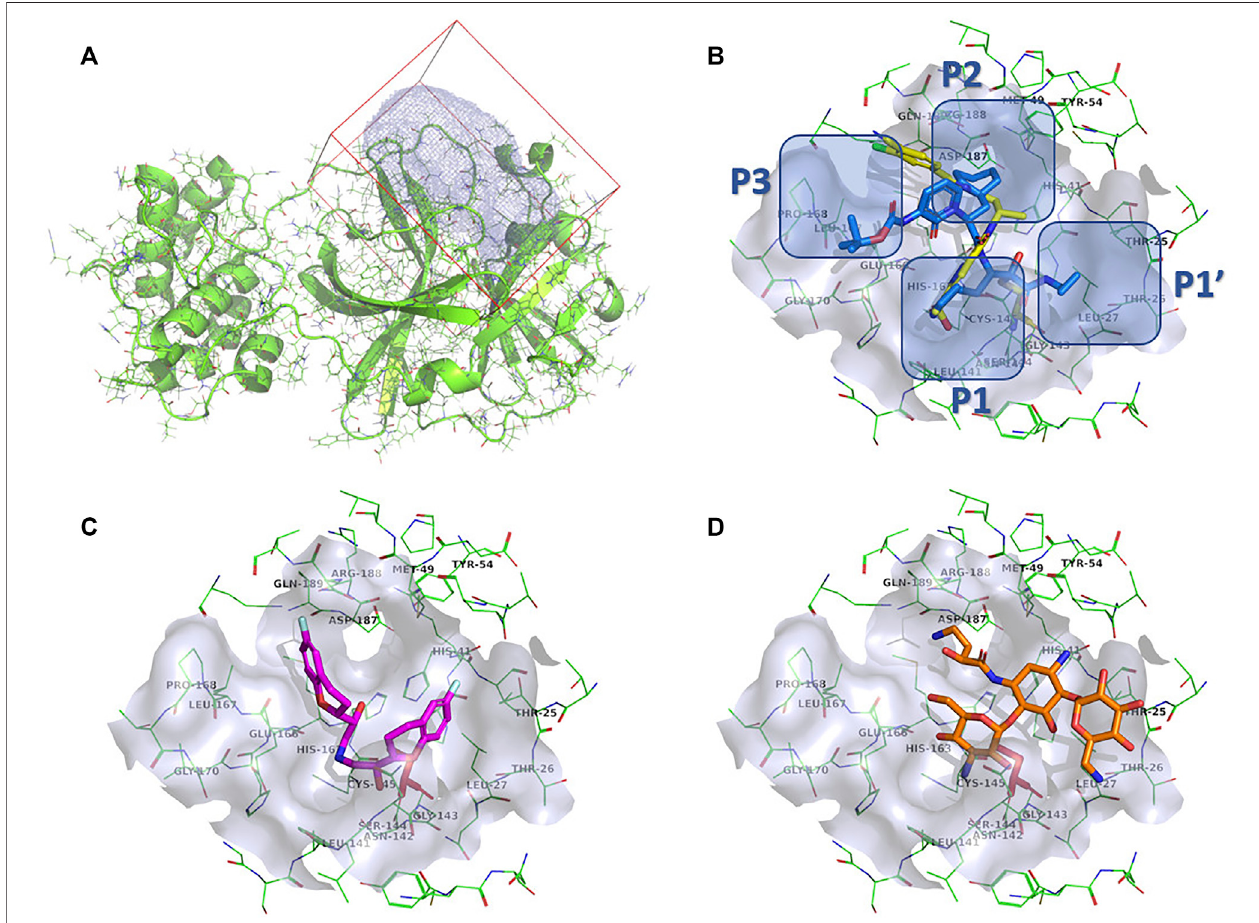
FIGURE4 |(A) : Prepared 3CL pro dockingtarget inthe green cartoon model with docking volume highlighted in blue mesh representation. (B) : Calculated docking pose of darolutamide shown in the yellow stick model superposed on the OEW reference ligand in the blue stick model. Emphasized are 3CL pro individual binding pockets. (C) :Calculateddockingposeofnebivololinthestickmodelcoloredmagenta. (D) :Calculateddockingposeofamikacinintheorange-coloredstickmodel.The 3CL pro protein is shown in a green-colored line model, with the active site surface in gray and catalytic Ser144 highlighted in a red-colored stick